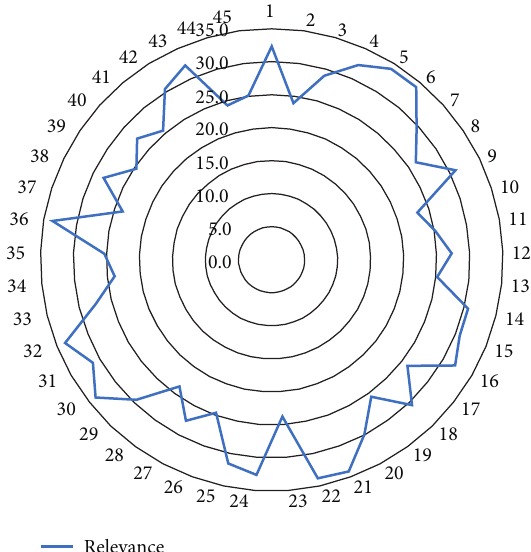
Figure 8: Statistical diagram on the relevance between virtual fi- nancial reform and GDP growth. Table 2: Relevance between virtual financial reform and GDP